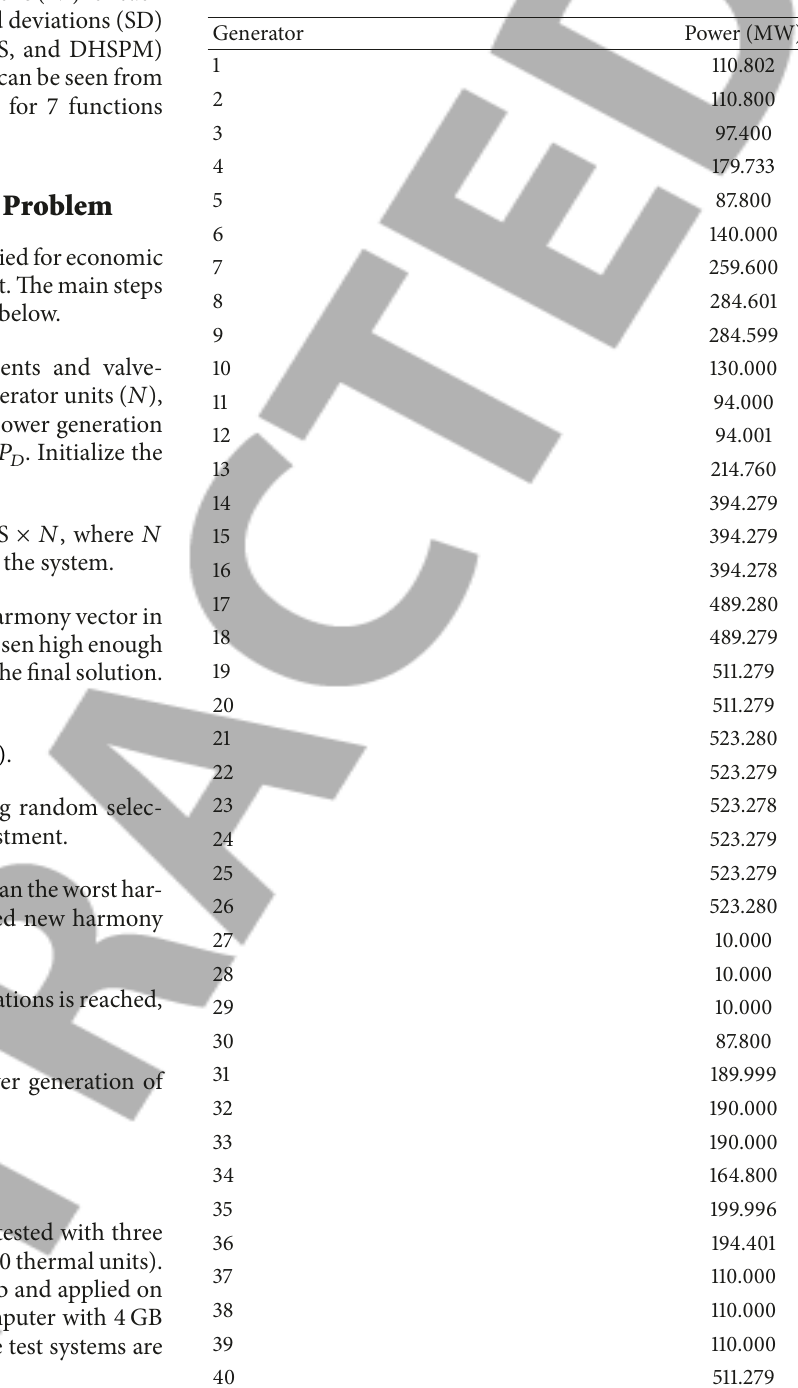
Table 10: 40 thermal units’ test